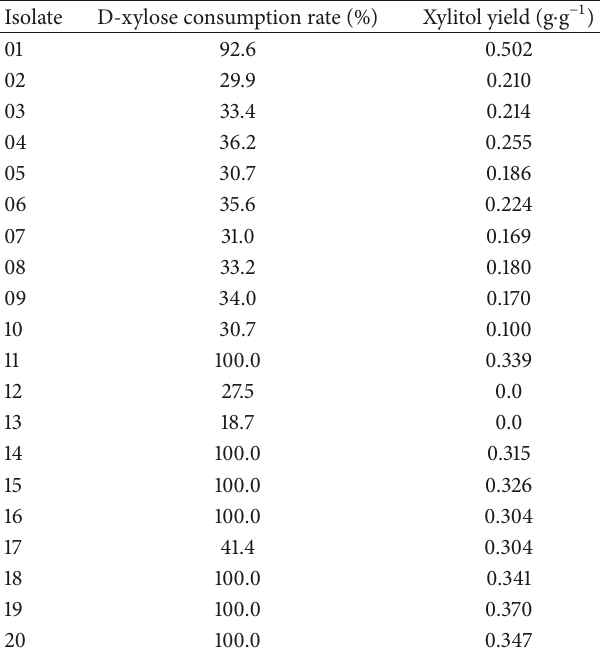
Table 3: D-xylose consumption rate (%) and xylitol yield of each